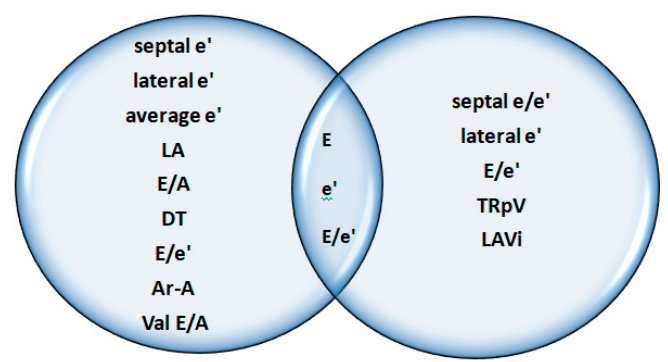
Figure 8. The main parameters included in 2009 and 2016 guidelines regarding LVDD. A: peak A wave velocity; Ar-A: difference between duration of A wave flow reversal and duration of the mitral A wave; E: peak E wave velocity; e’: early diastolic annular velocity e’ (septal, lateral, and average); E/A: E/A ratio; E/e’: ration between E velocity and mitral annular e’ velocity; LA left atrium; LAVi: left atrial volume indexed; DT: deceleration time of E wave; Val E/A: change in E/A with Valsalva maneuver; TRpV: peak velocity of tricuspidian regurgitation.